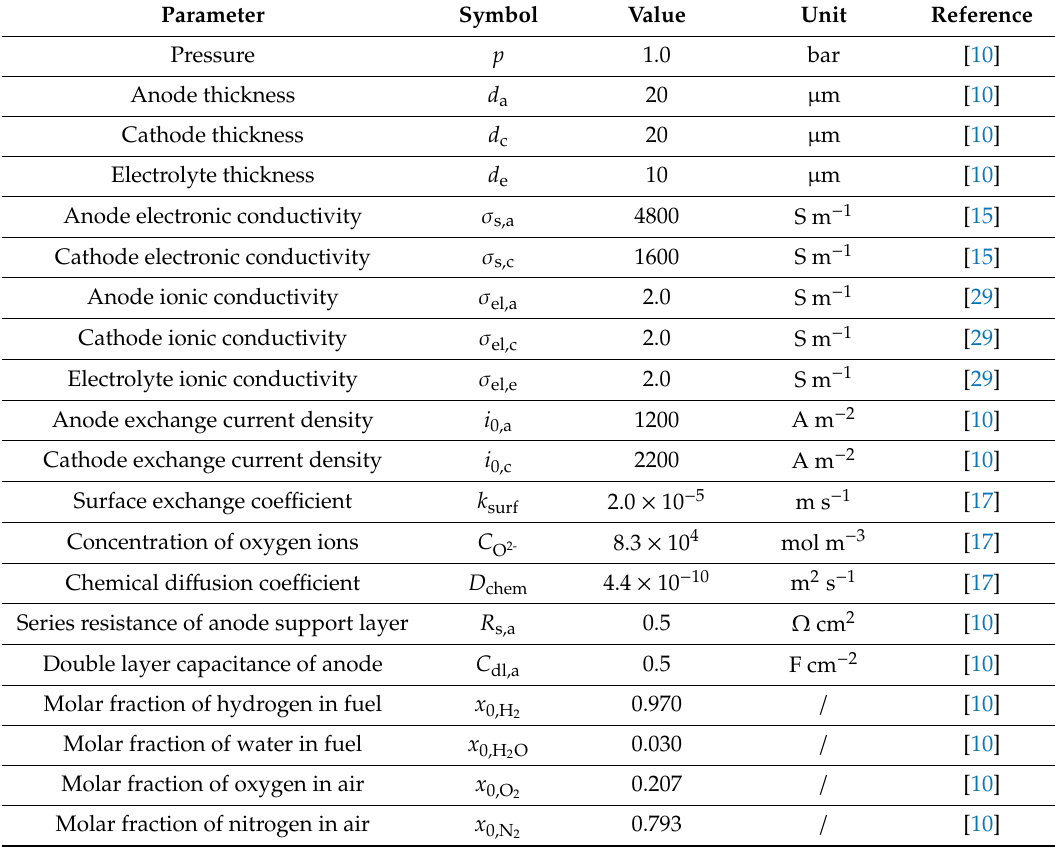
Table 2. Input parameters of the SOFC